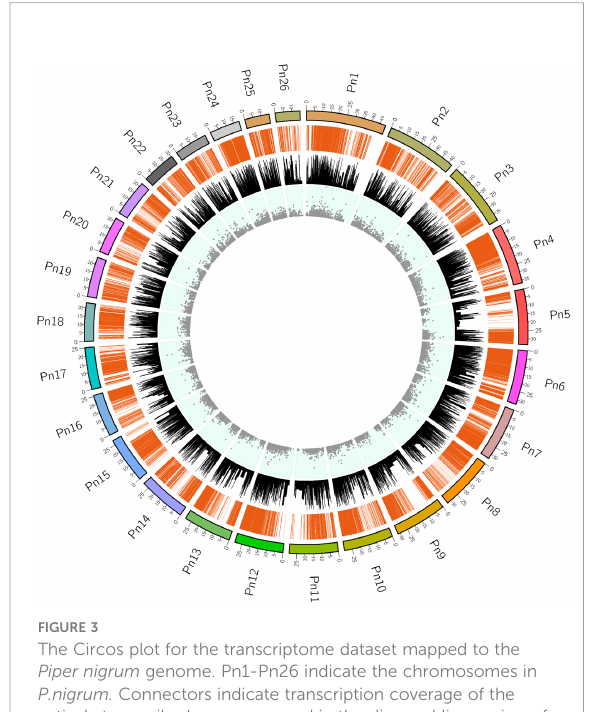
FIGURE 3 The Circos plot for the transcriptome dataset mapped to the Piper nigrum genome. Pn1-Pn26 indicate the chromosomes in P.nigrum. Connectors indicate transcription coverage of the actively transcribed genes mapped in the diagonal line region of the plot. An increased frequency of reads aligned denotes greater transcription activity when compared to other regions (outermost track). The sequence identity score with the Piper nigrum genome for the elevated expression transcripts aligned to a locus in comparison to the rest of the genome is shown in bar charts (middle track). The data points correspond to the composite scores of the transcripts aligned to the chromosome locus shown as a scatter plot (innermost